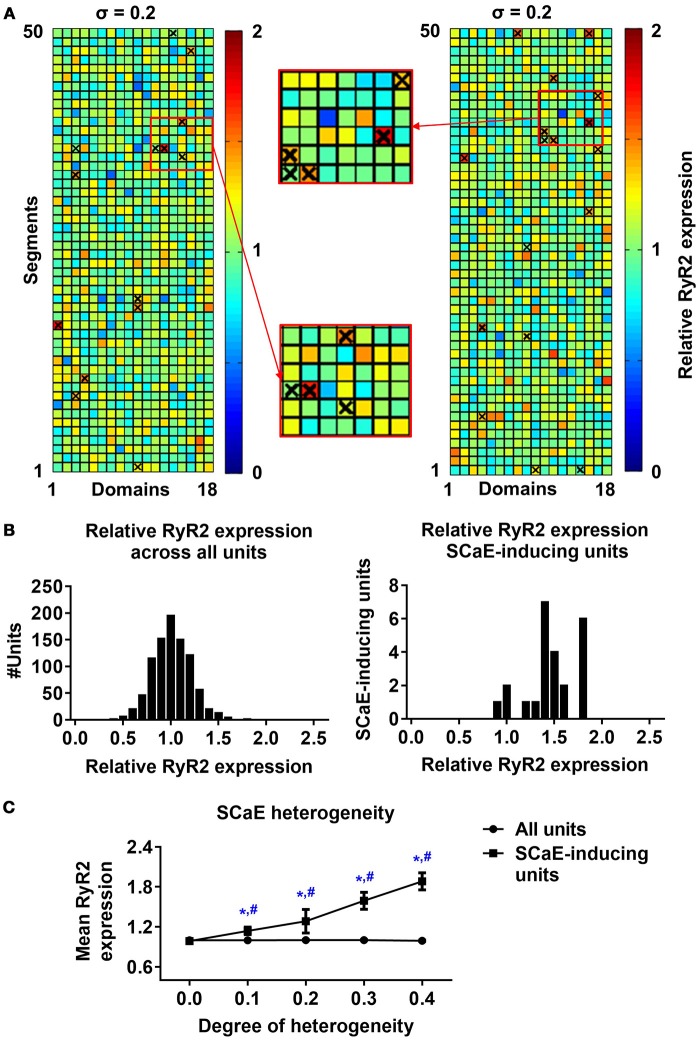
Origins of spontaneous Ca2+-release events (SCaEs). (A) Two representative examples of 50 × 18 matrices with heterogeneous RyR2 distribution (σ = 0.2). Red colors indicate high local RyR2 expression and blue colors low local RyR2 expression. The origins of individual Ca2+ waves are marked with crosses. Insets depict enlarged portions of the RyR2 distribution, showing that crosses mainly coincide with regions of high local RyR2 expression. (B) Histograms of relative RyR2 expression in all units (left) and units which were the origin of a SCaE (SCaE-inducing units). SCaEs arise mainly from units with high local RyR2 expression. (C) Mean relative RyR2 expression in SCaE-inducing units (squares) and all units (circles, 1.0 on average by definition) for different degrees of RyR2 heterogeneities. *indicates P < 0.05 vs. the group with heterogeneity 0.0 and #indicates P < 0.05 between mean relative RyR2 expression in SCaE-inducing units and all units; n = 6 per condition.